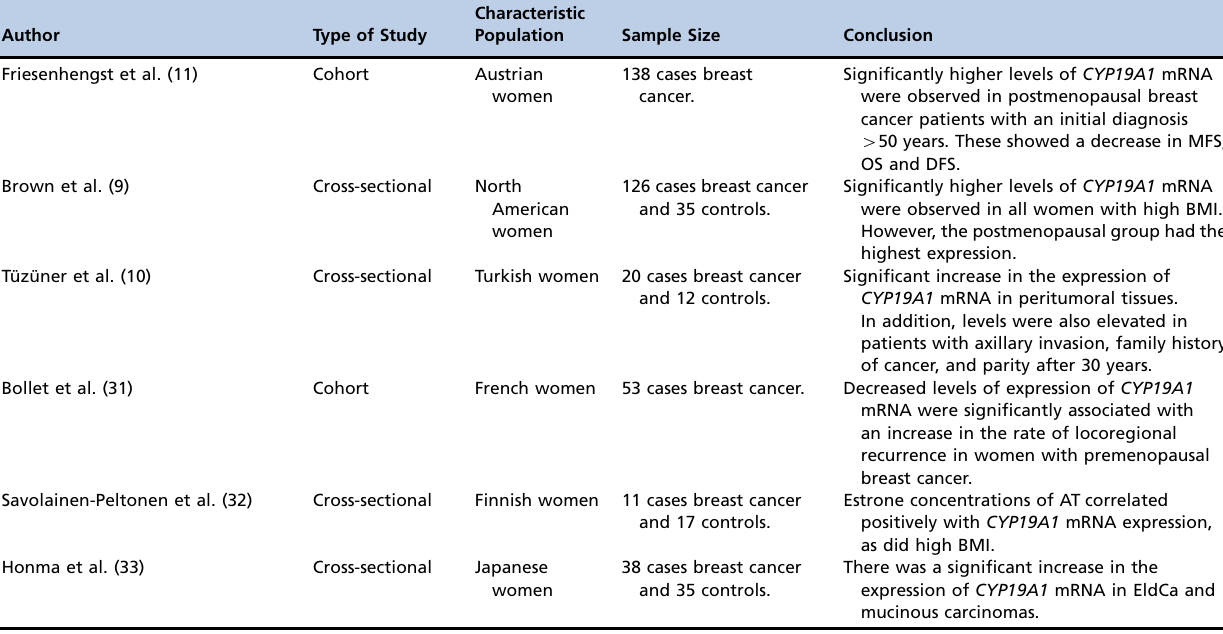
Table 1 - Description of the selected studies.